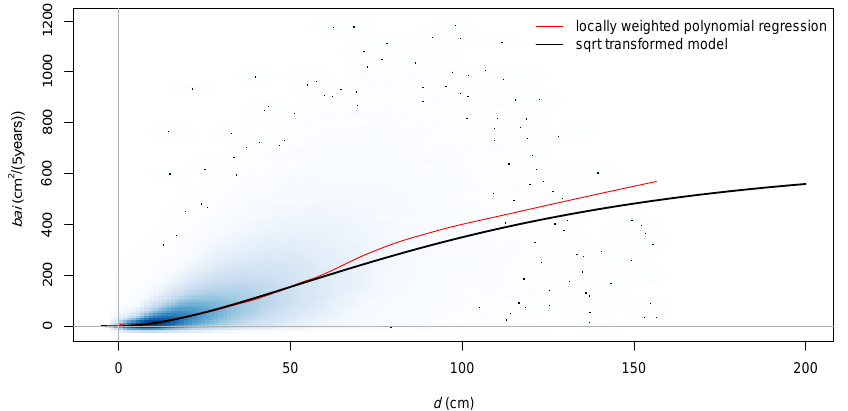
Figure 2. Observed basal area increment ( bai ) over diameter at breast height ( d ) for all species. Fifty-three percent of the variance is explained by a simple model (Equation (3), with g = Identity), using only d as explanatory variable. The blue background is the two-dimensional density of the observed d and bai . Dark blue contains more data, the 100 points indicate areas with the lowest